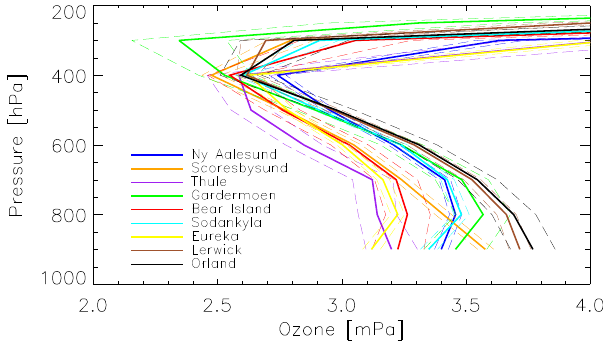
Figure 6. The long-term mean as a function of pressure (solid curves). Dashed curves indicate the 95% confidence intervals. Model settings: n pol = 4, n cyc = 2, n a tr = n θ tr = 0, and white